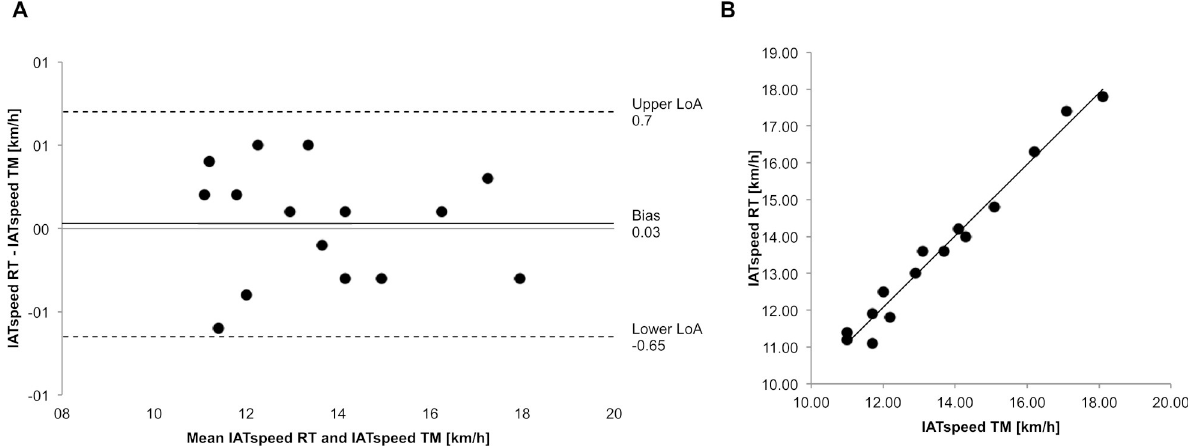
Fig 2. Agreement and strength of the relationship between TM and RT. (A) Bland-Altman plot to show the agreement of IAT speed and (B) Scatterplot of the IAT speed achieved for RT (y-axis) versus TM (x-axis) to show strength of